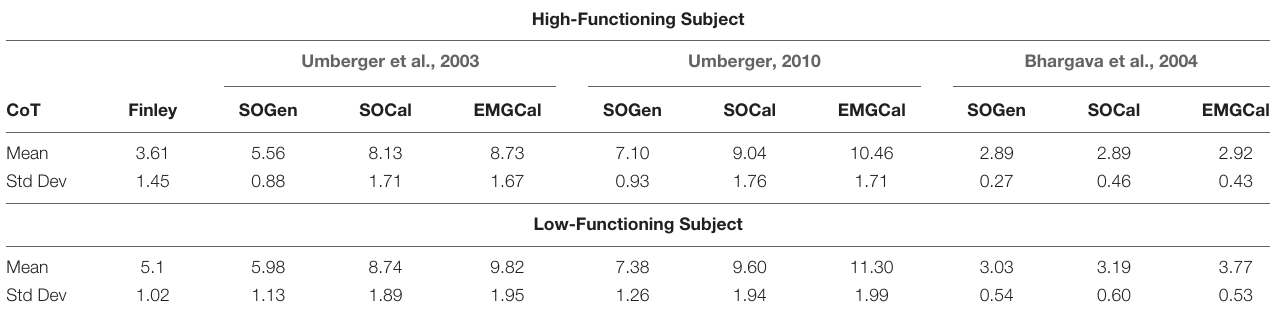
The high functioning subject (top) possessed a Fugl-Meyer score of 32, while low functioning subject (bottom) had a Fugl-Meyer score of 25. Experimental measurements used for comparison were taken from Finley subjects with similar Fugl-Meyer